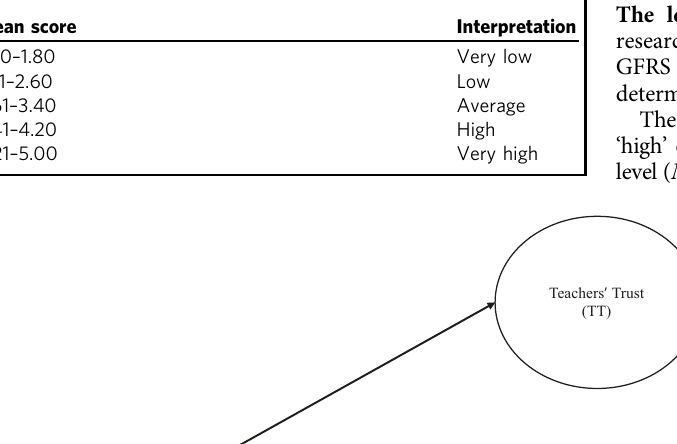
Table 3 Interpretation of mean scores.